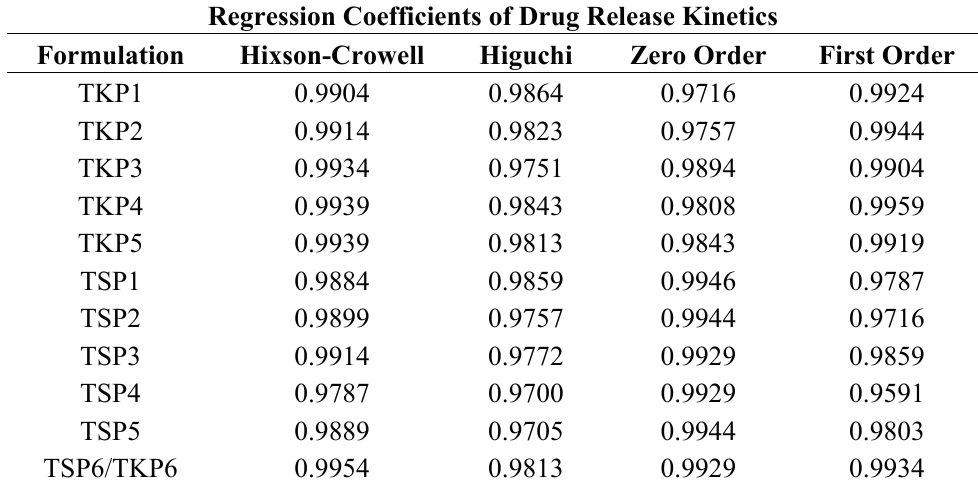
Table 3. Comparison of TSP and TKP regression coefficients of drug release kinetics for Hixson- Crowell, Higuchi kinetic model, first and zero order